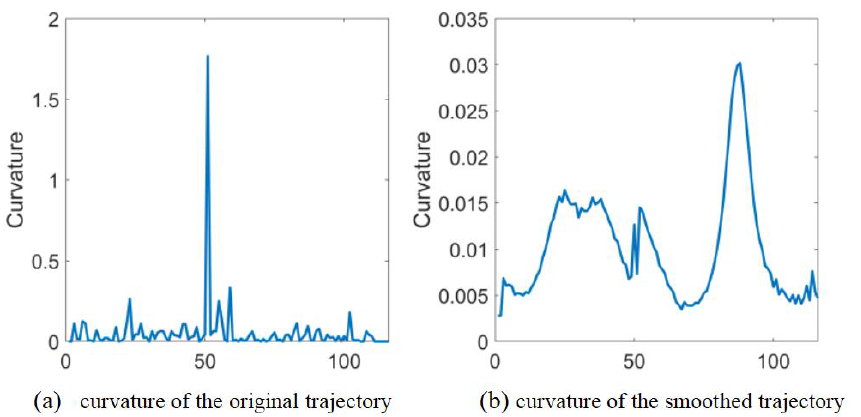
Figure 5. Curvature descriptor of the two trajectories in Fig. 4. The horizontal axis represents the numbers of the sampling of the path, and the vertical axis represents the curvature.